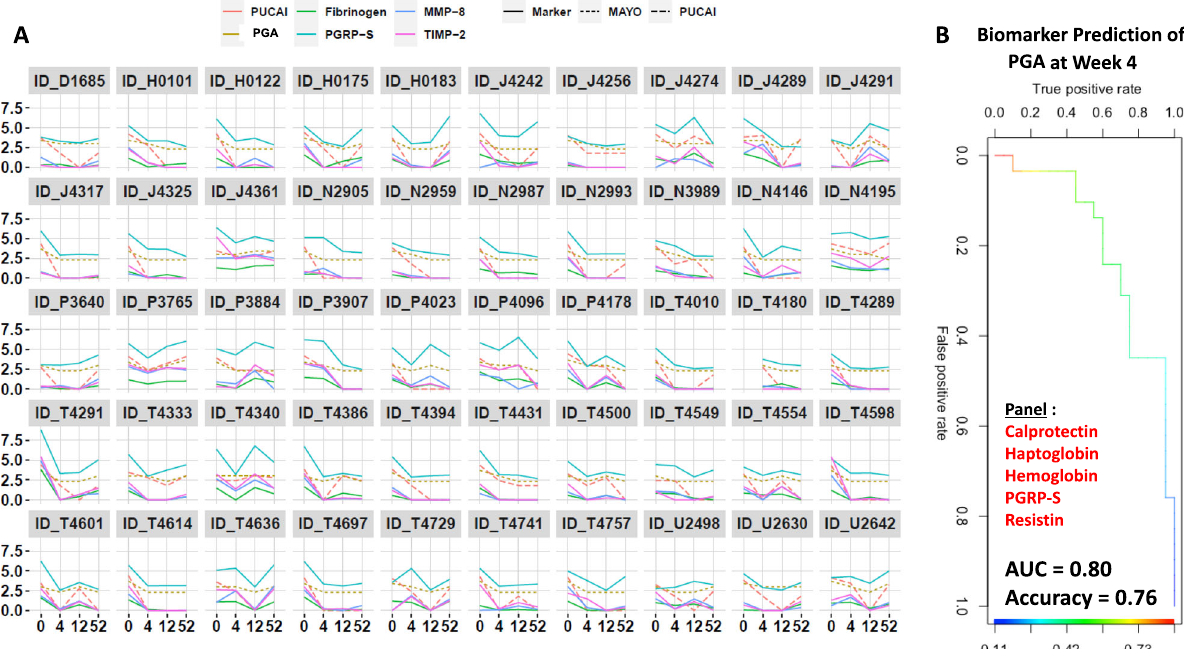
Fig. 5 Fecal Fibrinogen, MMP-8, PGRP-S, and TIMP-2 track with PUCAI and PGA indices in 50 UC patients from the PROTECT cohort followed up at 4 serial visits. A Expression of 4 selected stool proteins along with PUCAI and PGA disease severity index scores are plotted for each patient (total N = 50 UC patients from the PROTECT cohort). The X -axis shows the four-time points, whereas Y -axis shows the log-transformed values of stool makers, PUCAI, and PGA disease severity scores. B Biomarker panels that best predict concurrent disease activity (PGA Index at Week 4 follow up) were determined using elastic-net regularized logistic regression, after adjusting for age, gender, ethnicity, and medication use. The best panel comprises stool Calprotectin, Haptoglobin, Hemoglobin, PGRP-S, and Resistin, with an accuracy of 0.76 and AUC of 0.80 (95% CI: 0.68 – 0.93). Indeed, this prediction accuracy increases to 0.80, when the model is further adjusted for the PGA score at baseline.